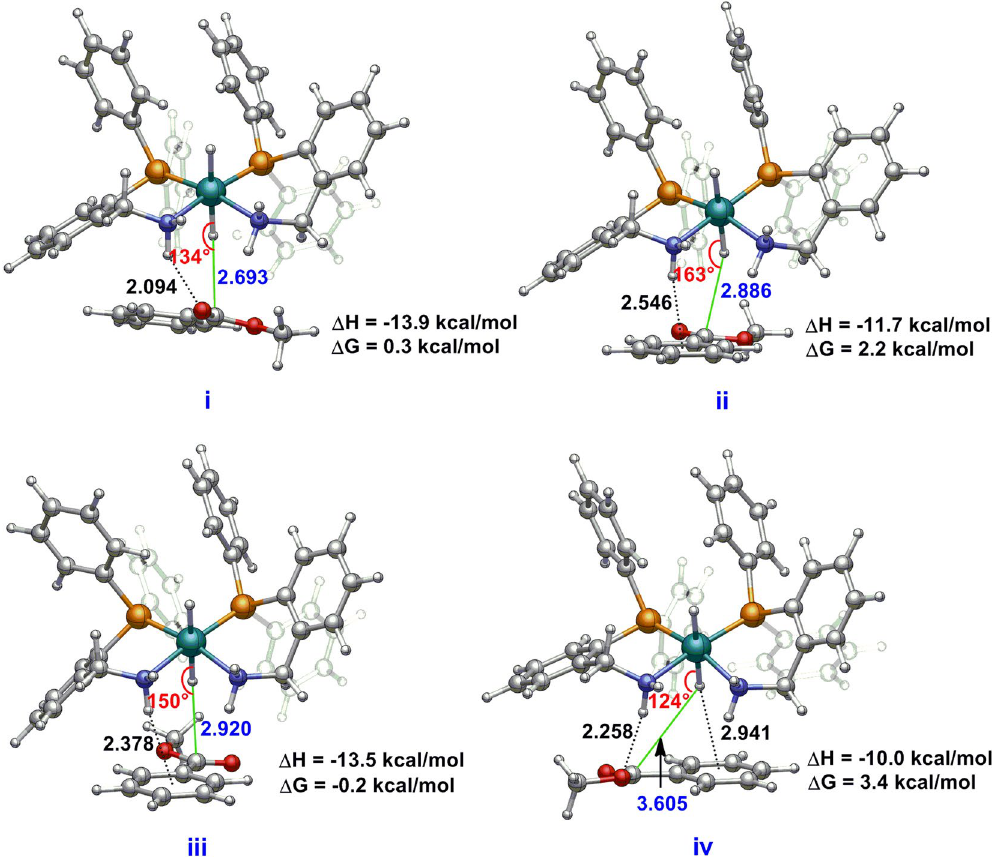
Figure 8. Optimized structures of the reactive conformers for the reaction system 3H-MB by DFT + D